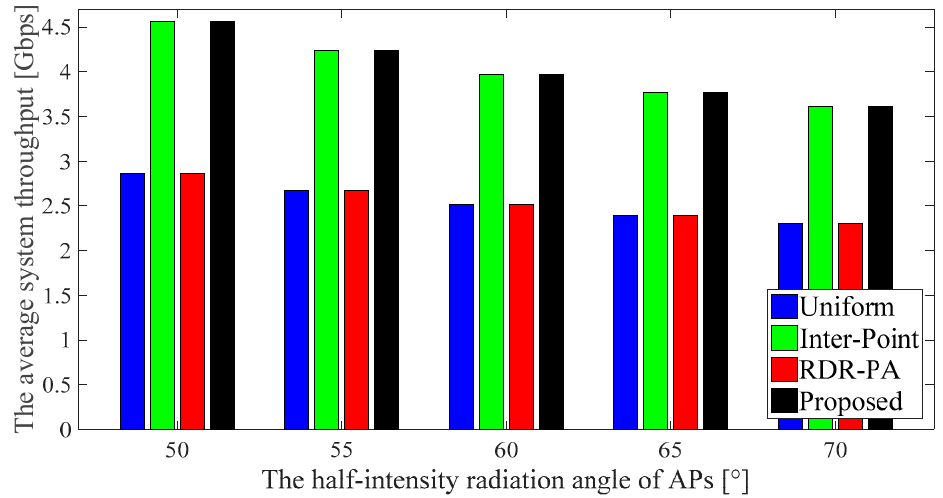
Figure 13. The average system throughput versus half-intensity radiation angle.